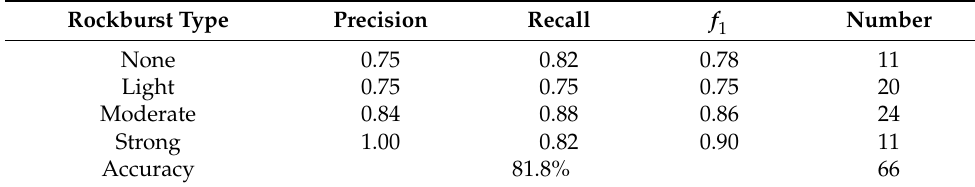
Table 12. The testing performance of the CRF